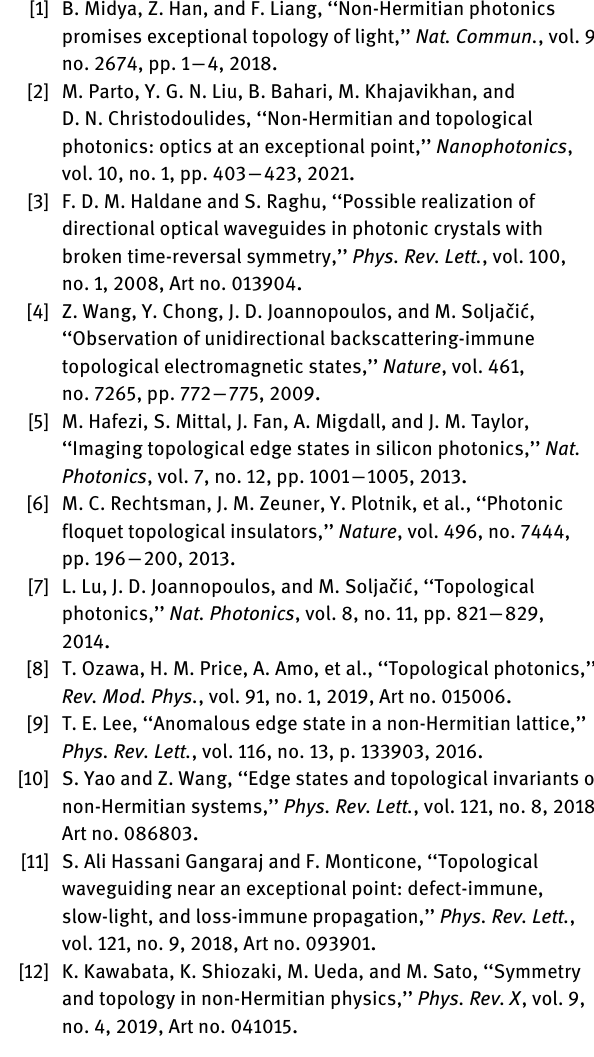
) is placed at a distance f (Figure 3). A Bertrand lens (focal length f b b from the focal plane of the initial lens, such that the output of the Bertrand lens is the k -space image of the sample. This technique is also known as back focal plane imaging. The k -space image passes through an aperture, allowing the incident angles ( 𝜃 ) to be resolved. Different in-plane angles ( 𝜙 ) are probed by rotating the